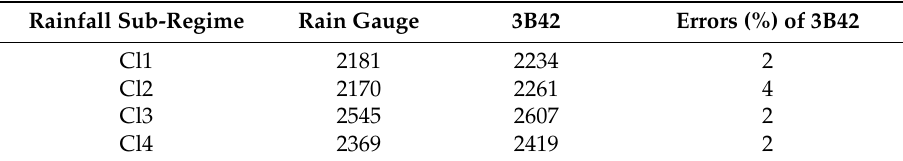
Table 3. Rain gauge and 3B42 mean annual rainfall (in mm) for each rainfall sub-regime of the northeastern